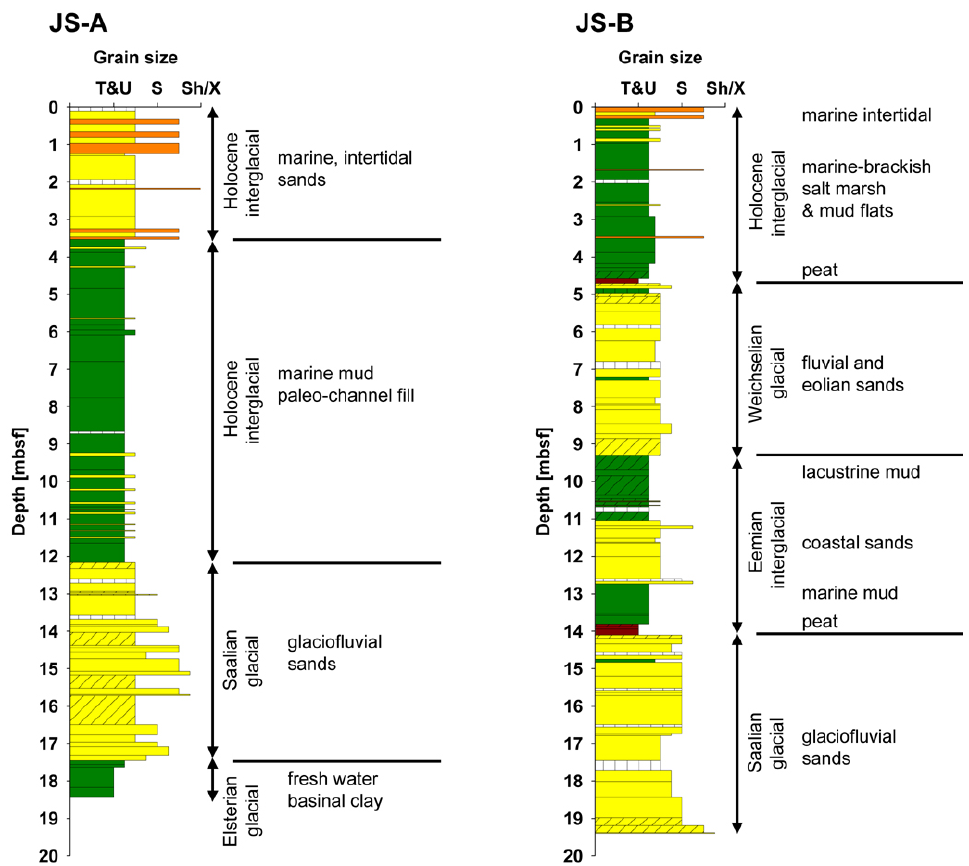
Fig. 2. Lithological profiles of the two sediment cores JS-A and JS-B. Core JS-A shows Holocene sediments filling a paleo-channel. Core JS-B displays a mainly Pleistocene sedimentary succession deposited since the Saalian glaciation more than 130000 years ago. T&U, S, Sh indicate mud, sand, and shells, respectively. Orange: shell bed, yellow: sand, green: mud, red: peat, diagonally hatched: intervals stained by humous matter, white vertically hatched: core loss. Sediment cores were collected in November